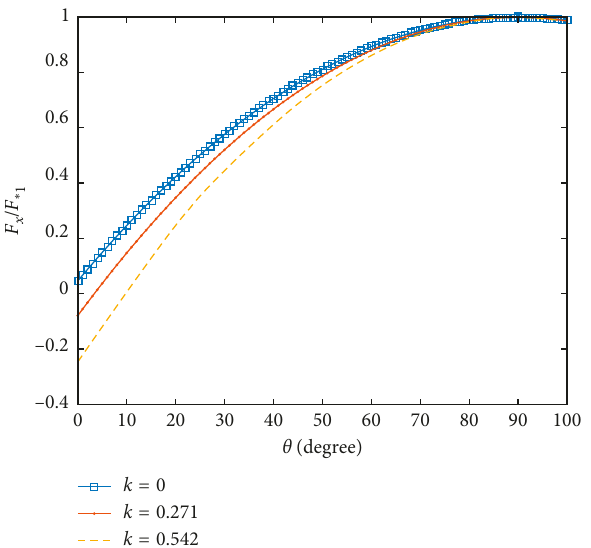
Figure 6: Force on the dislocation b angular position θ .